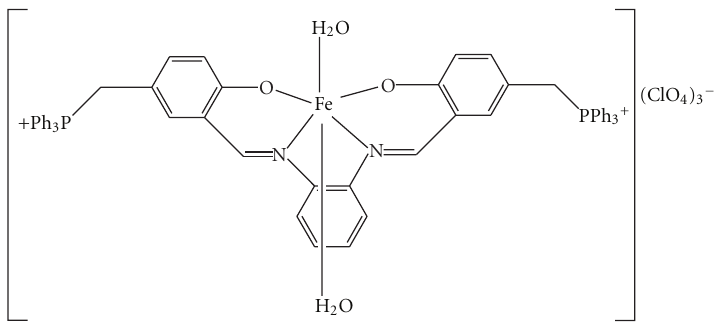
Figure 1: The molecular structure of iron(III)